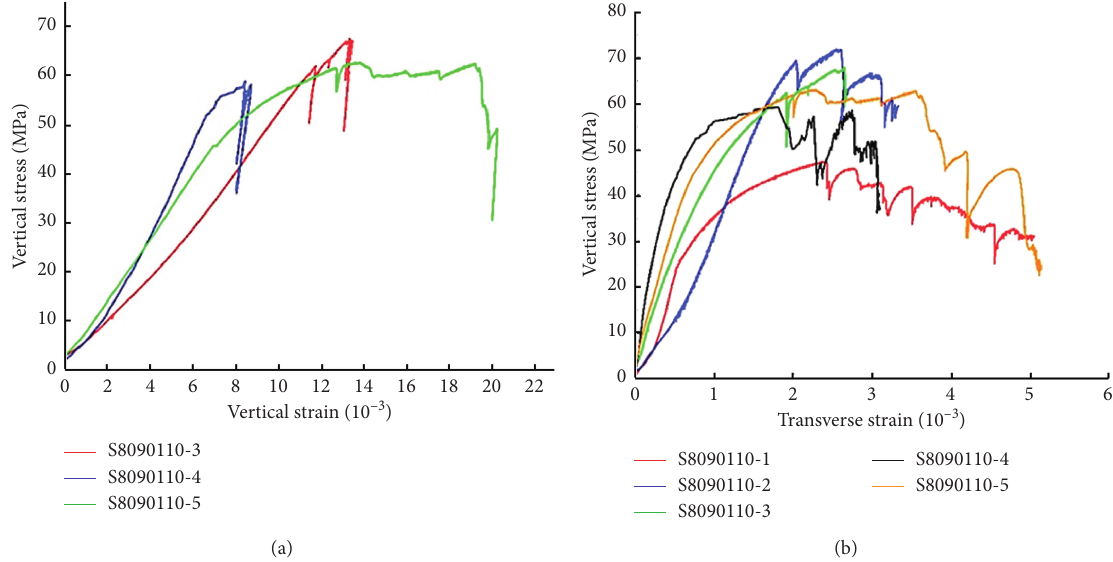
Figure 11: Stress versus strain curves of the cubic sandstone samples. (a) Vertical stress-vertical strain curve of the sandstone sample. (b) Vertical stress-transverse strain curve of the sandstone sample.